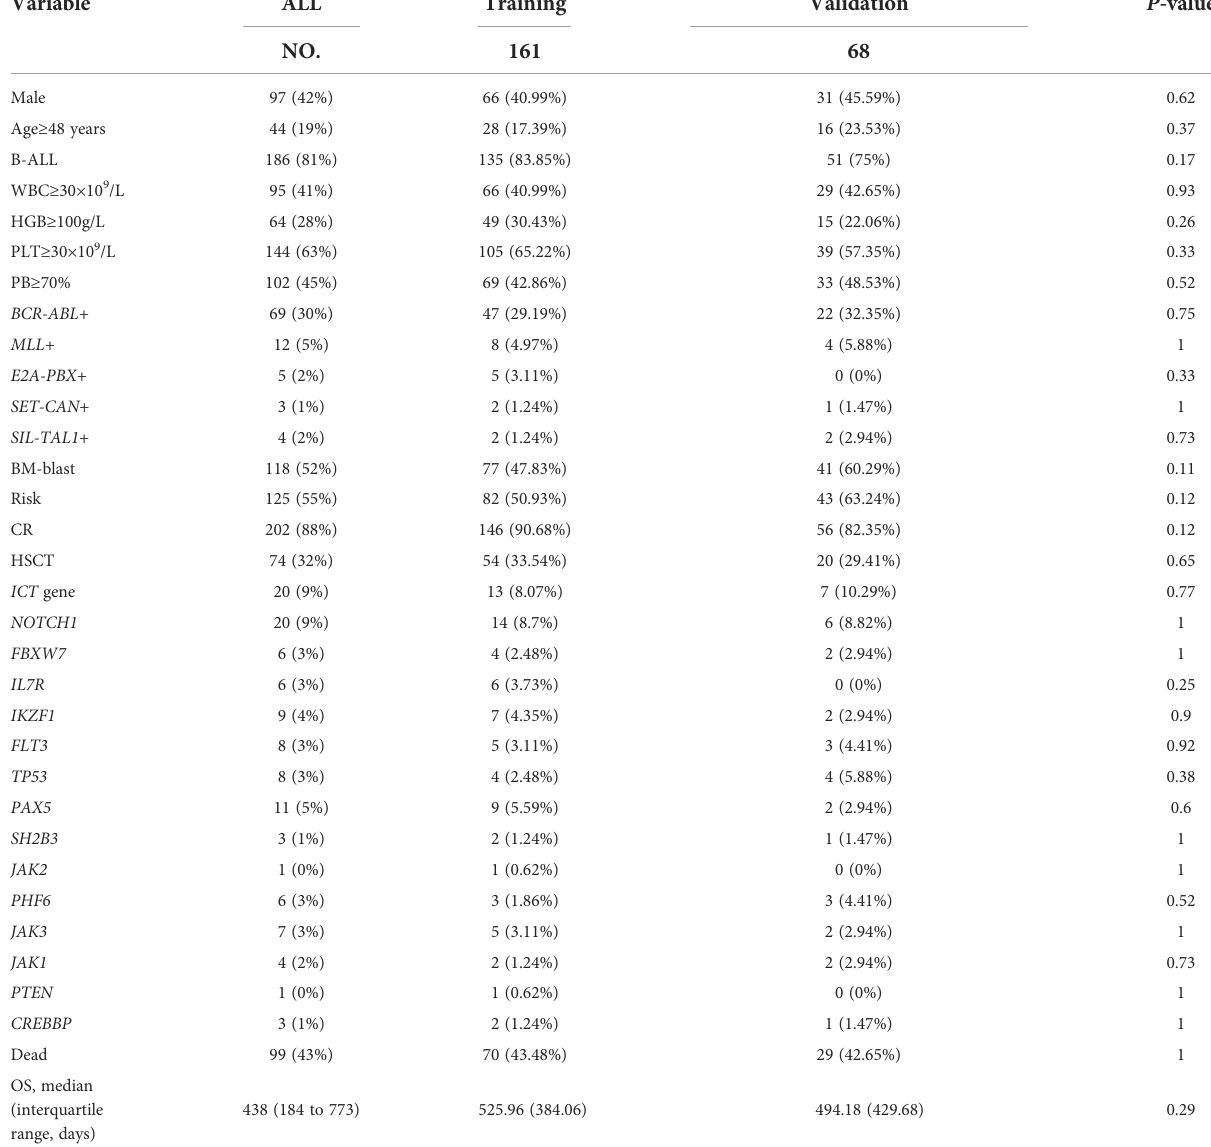
TABLE 1 Comparision of the training cohort and the validation cohort. Variable